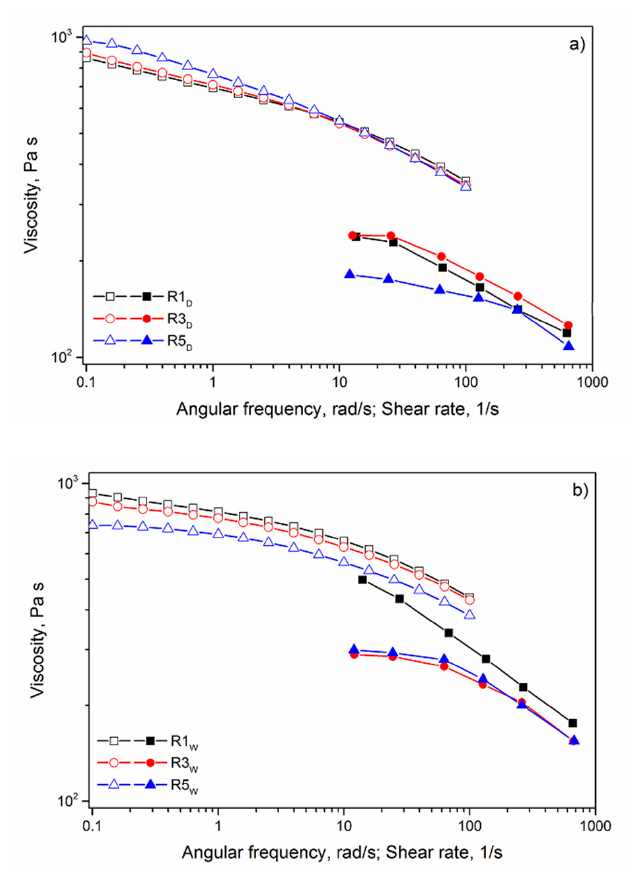
Figure 1. Flow curves of the Ecovio after 1, 3, and 5 extrusions steps for ( a ) dried sample and ( b ) wet sample. Data taken from rotational rheometer (open symbols) and capillary viscometer (closed